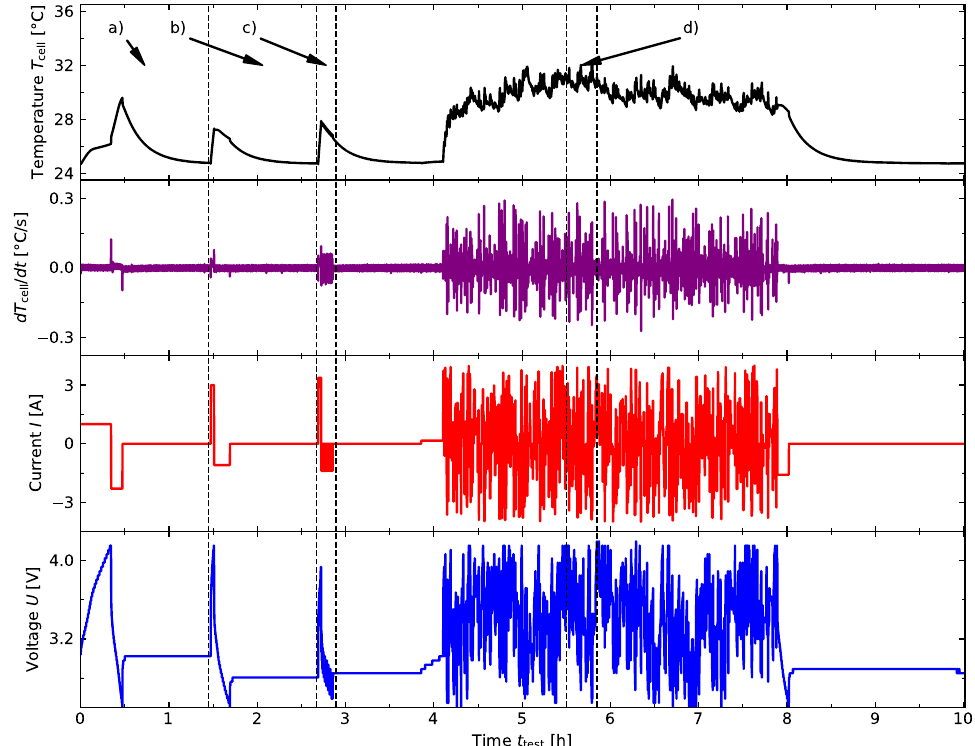
Figure 5. Selected data to test the algorithm. Presented are four subfigures showing temperature response T cell ( t test ) , temperature change over time dT cell / dt ( t test ) , current profile I ( t test ) and voltage response U ( t test ) . Four areas are marked ( a – d